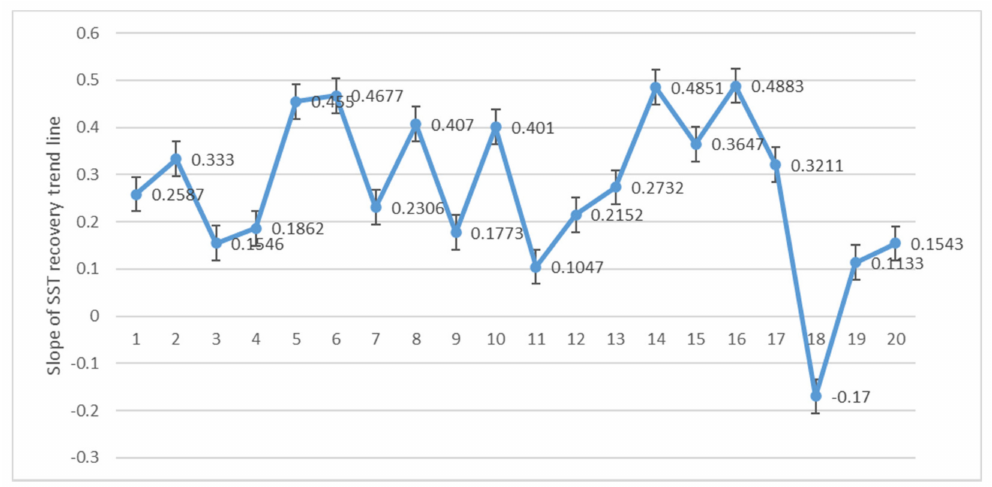
Figure 6. Slope of sea surface temperature recovery trend line after Typhoon. Typhoon Lingling formed in the sea off the eastern coastal line of the Philippines at 0:00 on 6 November 2001, as a tropical depression, strengthening into a typhoon at 18:00 on that day. After passing through the South China Sea, the SST on the right side of the path decreased significantly, and the maximum cooling range was 6.45 ◦ C. An obvious cold vortex appeared on the right side of the typhoon track, and the response lasted for 12 days, as shown in Figure